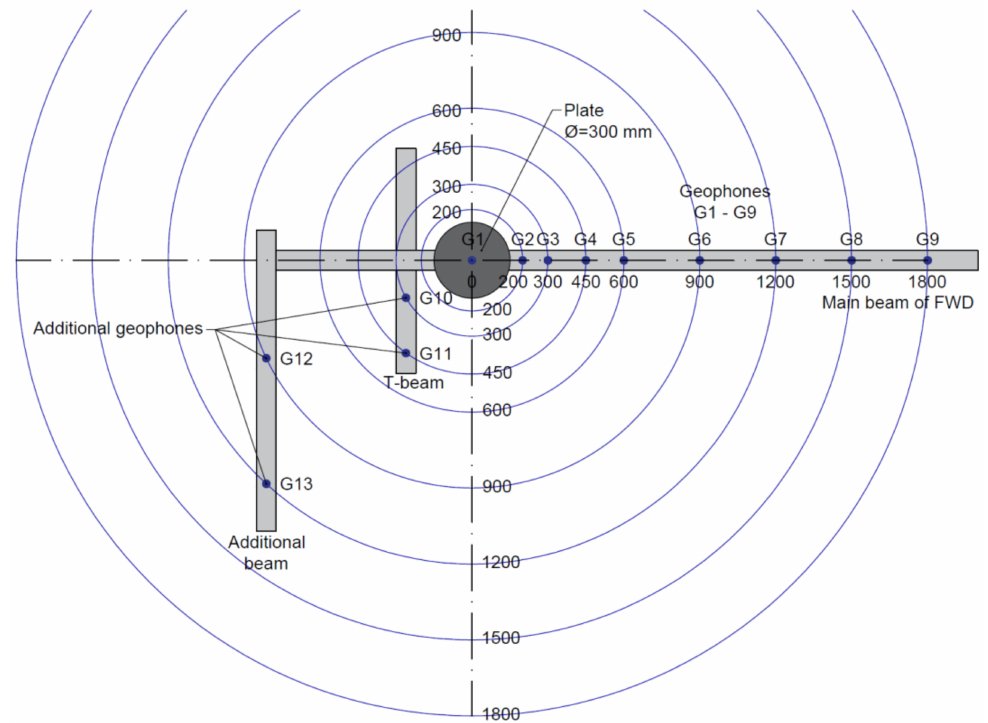
Figure 4. Scheme of the